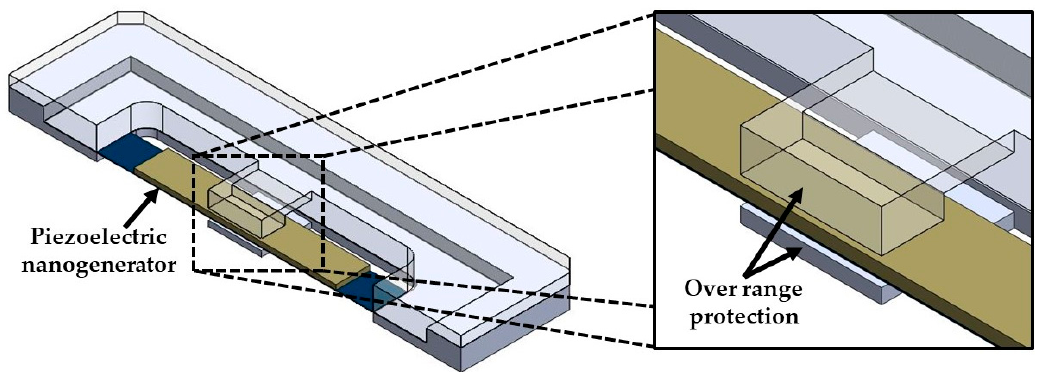
Figure 17. Cross-section view of the over range protection of the maximum deflection of the piezoelectric nanogenerator. Table 5. Total output power and power density of the nanogenerator under different accelerations in y -direction.